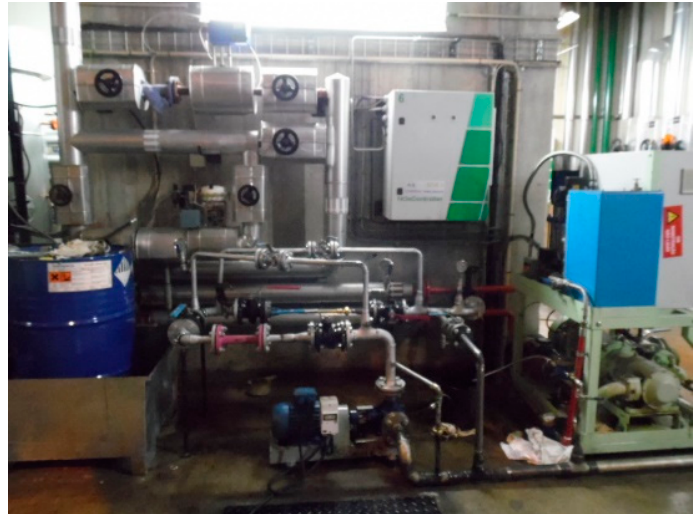
Figure 11. Cavitator system in the fuel circuit.